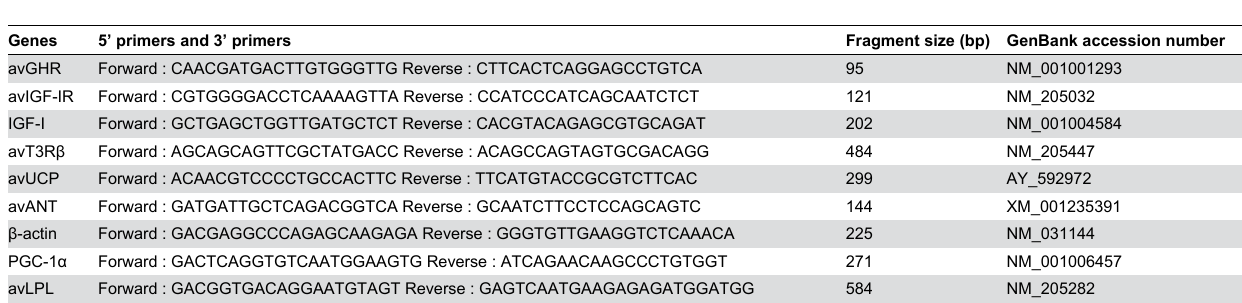
Table 1. Primers defined according to chicken ( Gallus gallus ) gene sequences.